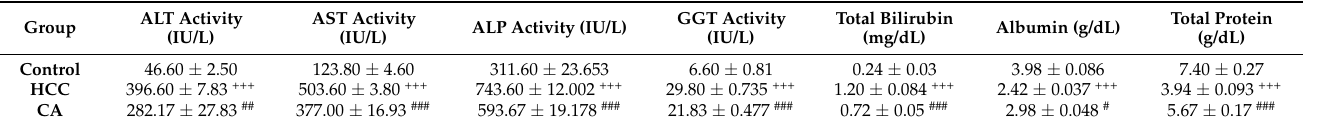
Table 1. Effect of CA on liver function parameters.